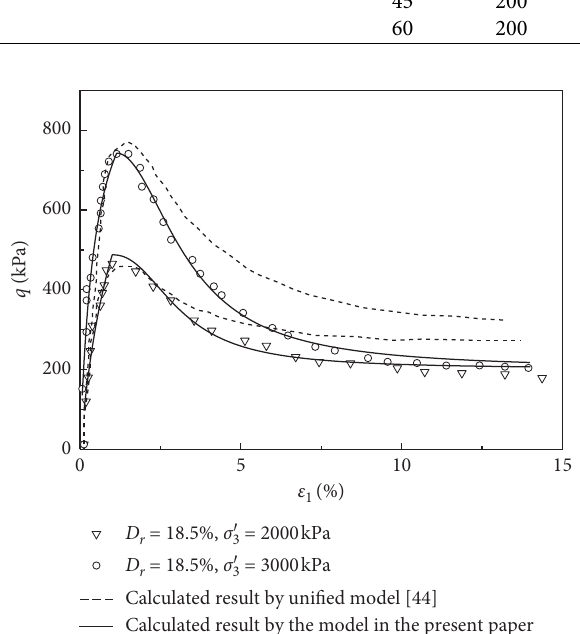
Figure 14: Comparison between test data and calculated result for undrained Toyoura sand.